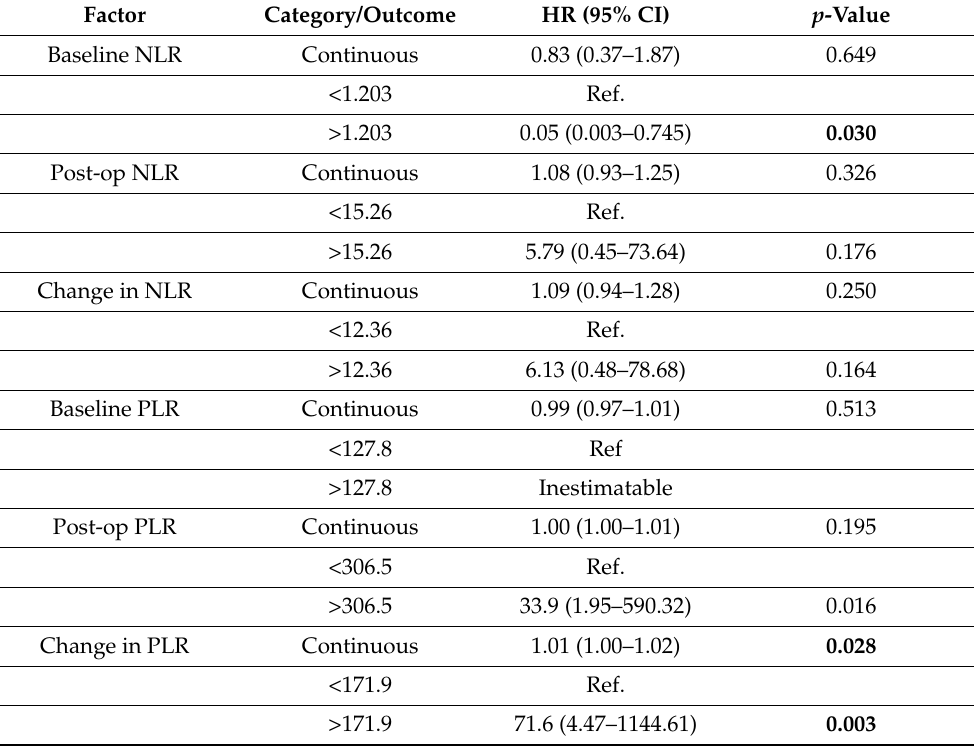
Table 8. Multivariable analysis of association between NLR, PLR and metastasis-free survival.